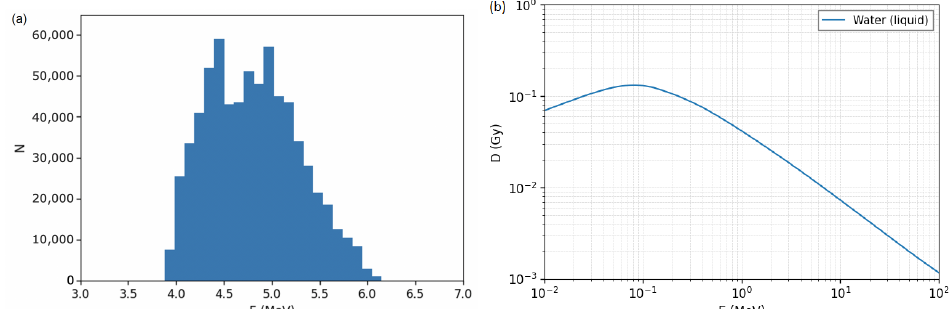
Figure 3. ( a ) Spectral distribution of protons in a 0.25 cm 2 area at the surface of the cell culture dish for one of the simulated configurations ( L p = 70 mm, E c = 5 MeV). ( b ) Correlation between proton energy and dose deposition in water for a fluence Φ = 10 6 /cm 2